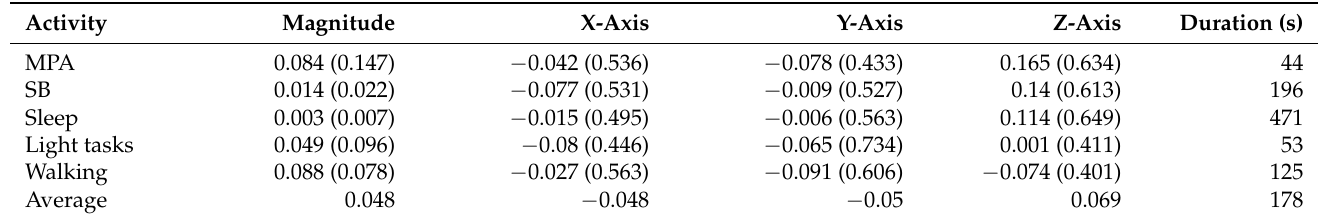
Table 3. Average acceleration and duration of each activity, for the labelled data by Willetts et al. [7]. Data presented as means and standard deviations. SB—sedentary behaviour.